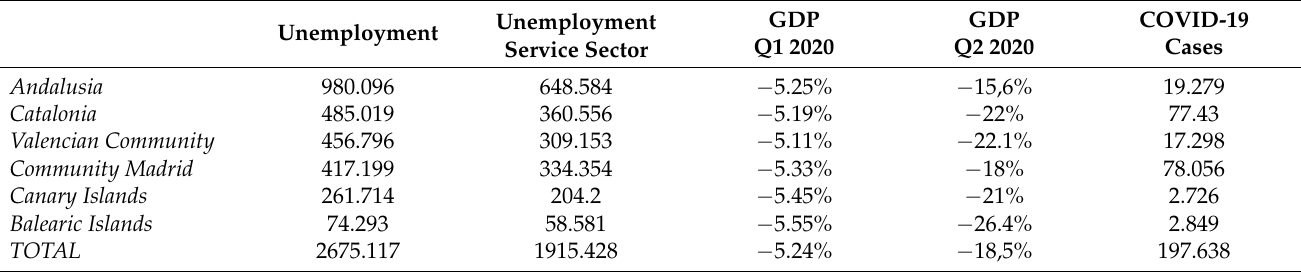
Table 1. Regions most impacted by the Covid-19